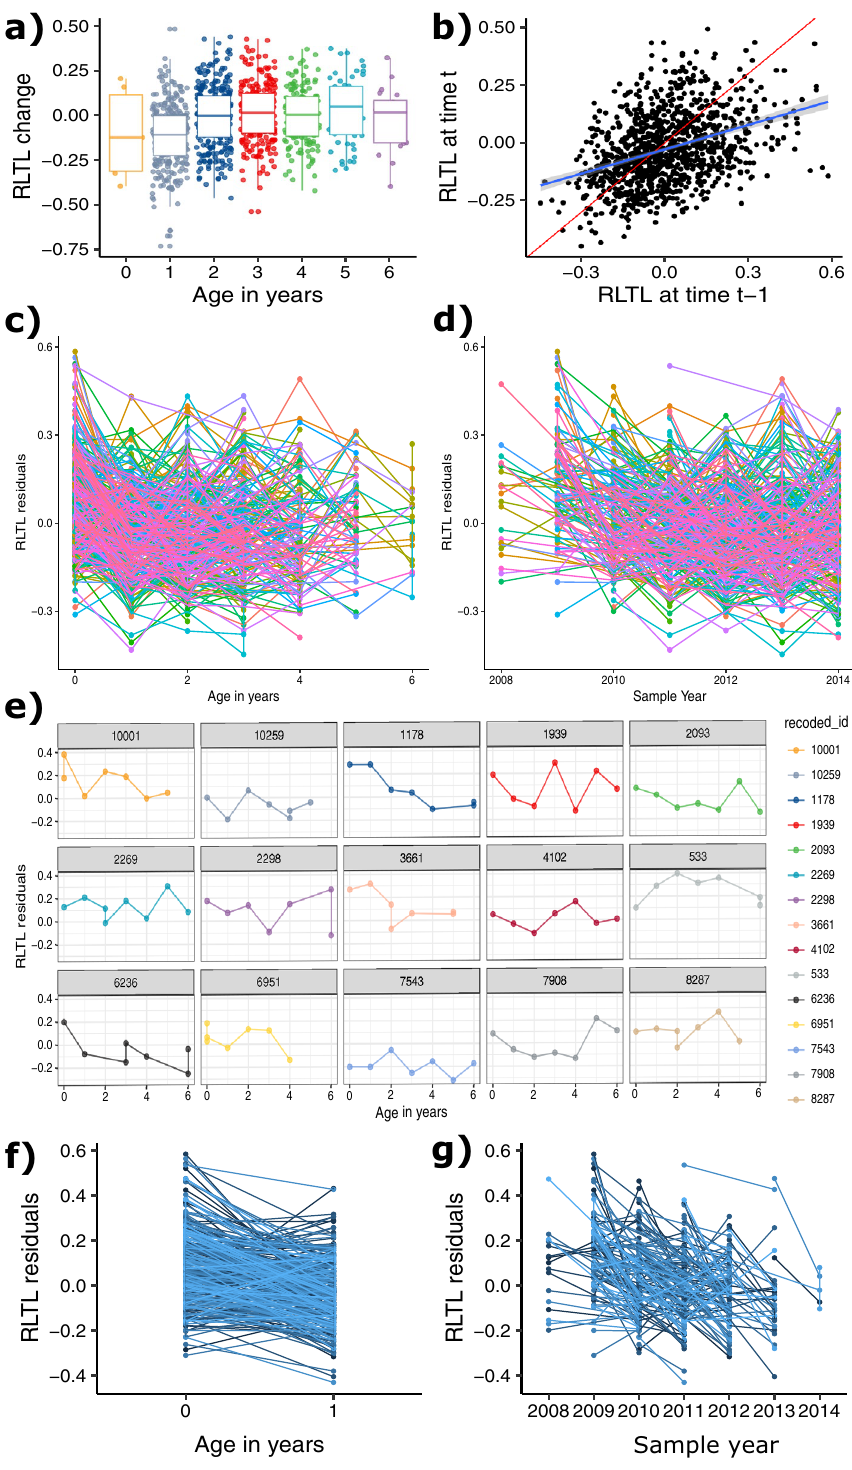
Figure 1. Relative leukocyte telomere length (RLTL) dynamics in dairy cattle. All RLTL measurements were pre-adjusted for qPCR plate and qPCR row to account for known sources of measurement error. ( a ) Age in years at second RLTL measurement is significantly associated with RLTL change. ( b ) At all measurement times the present measurement (RLTL at time t) is clearly correlated with the previous measurement (RLTL at time t − 1) (estimate = 0.38, P < 0.001). The red line represents a perfect correlation. ( c ) RLTL over age in years. ( d ) RLTL over sample year. ( e ) Longitudinal RLTL change over age for all animals with at least 7 samples as example for RLTL variation. ( f ) Early-life change in RLTL over age at sampling and ( g ) over sampling